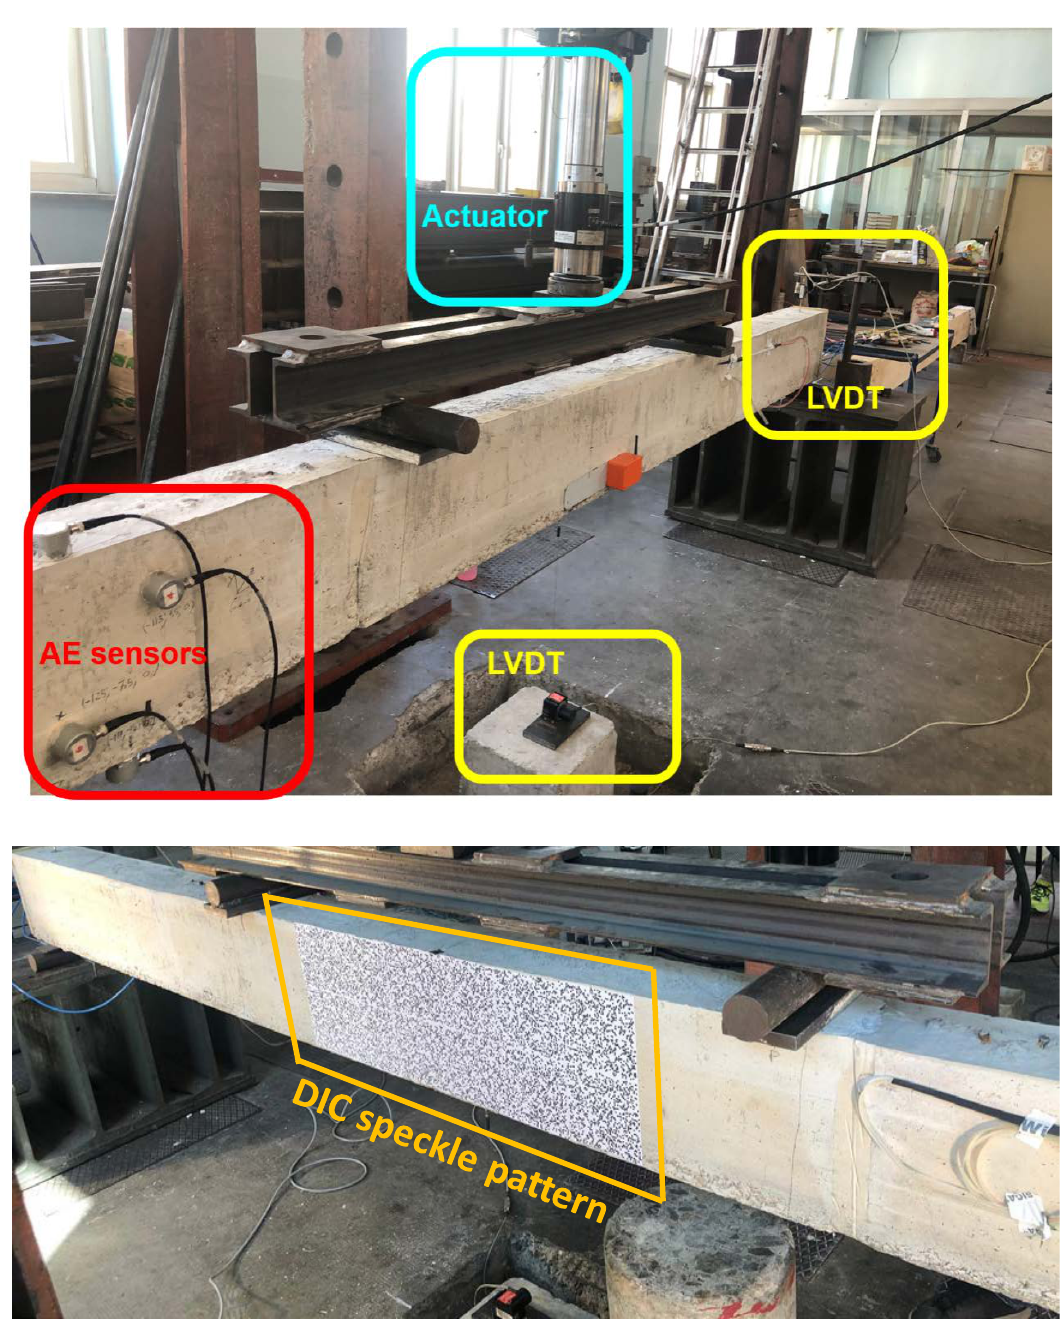
Figure 2. Front (top) and back (bottom) sides of the test setup showing the servo hydraulic actuator, the linear variable differential transformer (LVDT) sensors, the location of some AE sensors, and the speckle pattern on the central beam surface for digital image correlation (DIC) applications.